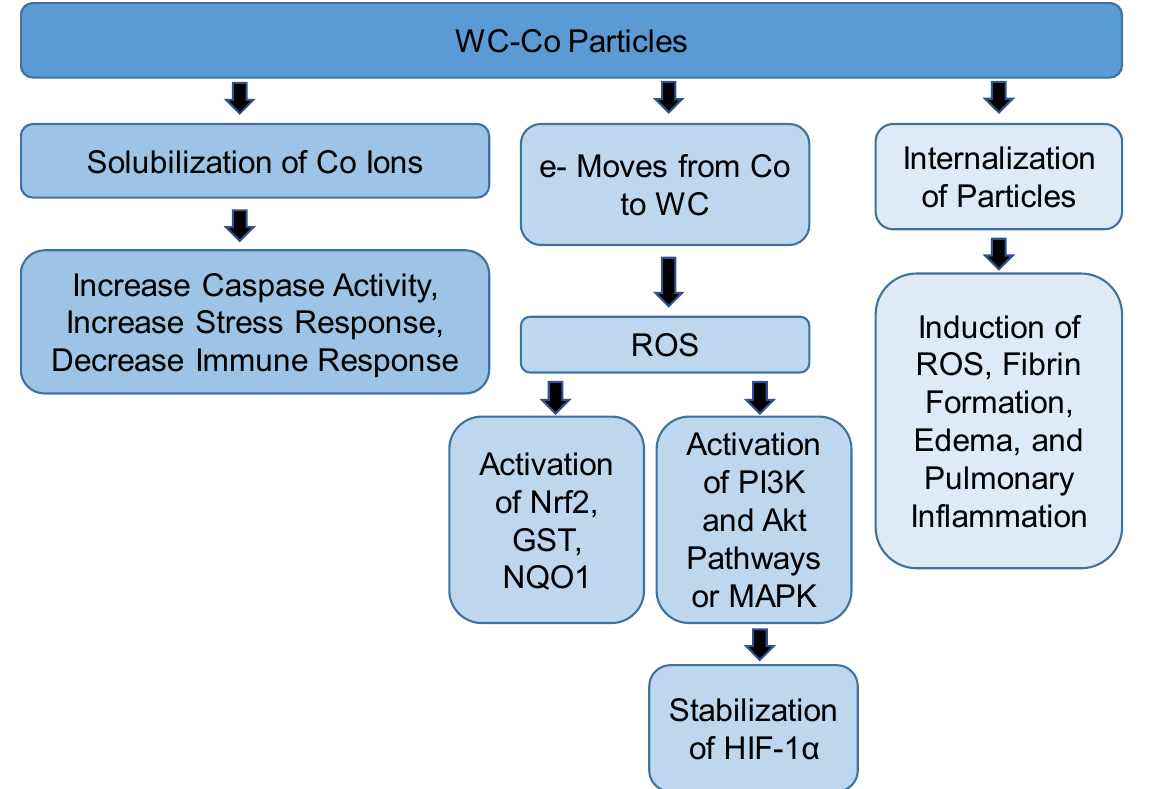
Figure 2. Summary of the proposed mechanisms of tungsten carbide ‐ cobalt (WC ‐ Co) toxicity. Akt: protein kinase B; GST: glutathione S ‐ transferase; HIF ‐ 1 α : hypoxia inducible factor 1 ‐α ; MAPK: mitogen ‐ activated protein kinase; NQO1: NADPH dehydrogenase quinone 1; Nrf2: nuclear factor erythroid 2 ‐ like factor 2; PI3K: phosphatidyl inositol 3 kinase; ROS: reactive oxygen species.